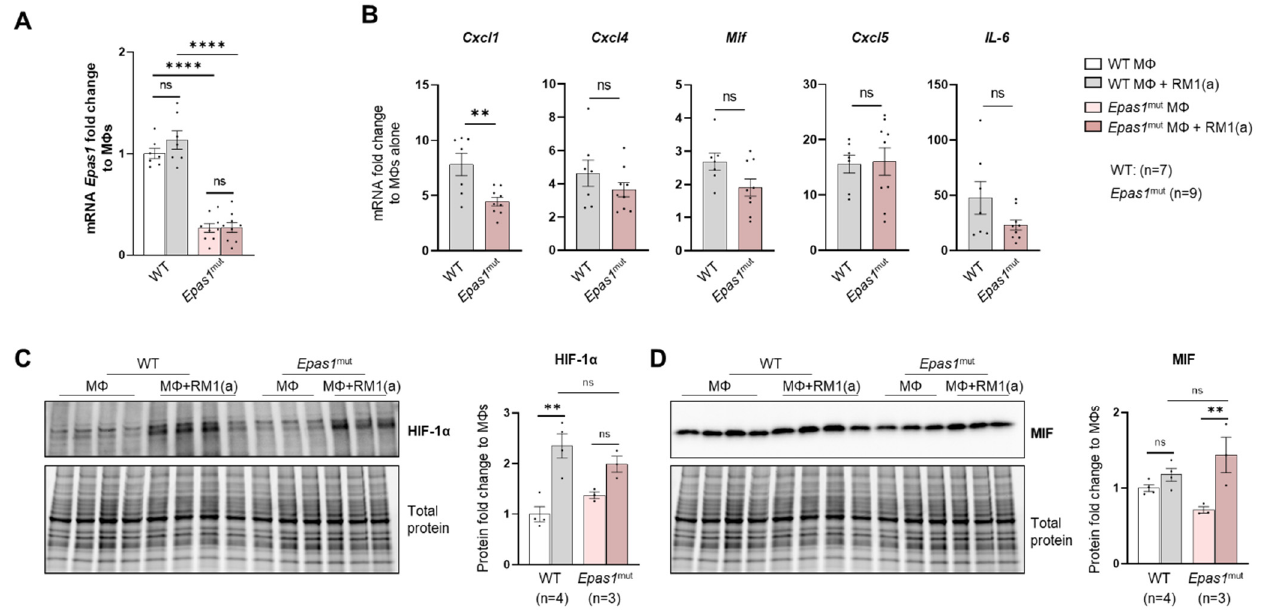
Figure A10. HIF-2 α depletion ( Epas1 mut ) effect in efferocytic bone marrow macrophages. BM macrophages (M Φ ) were isolated from 4 wk old Epas1 flox/flox (WT), Epas1 mut mice and co-cultured with apoptotic RM1cells (RM1(a)) for 16–18 h. ( A ) Epas1 mRNA expression in Epas1 flox/flox (WT) and Epas1 mut BM macrophages (M Φ ). ( B ) mRNA from efferocytic and control BM macrophages from WT ( n = 7) and Epas1 mut ( n = 9) mice were analyzed by RT-qPCR for the specified inflammatory cytokine genes. ( C , D ) Protein lysates from efferocytic and control BM macrophages from WT ( n = 4) and Epas1 mut ( n = 3) mice were analyzed by Western blot with HIF-1 α and MIF antibodies. Fold change was calculated relative to WT non-efferocytic BM macrophages ( A , C , D ) or to its own non-efferocytic BM macrophage control ( B ). Plotted data are shown as mean ± SEM. ** p < 0.01, **** p < 0.0001, ns = not significant (ordinary one-way ANOVA; Tukey’s multiple comparison test and unpaired t -test).